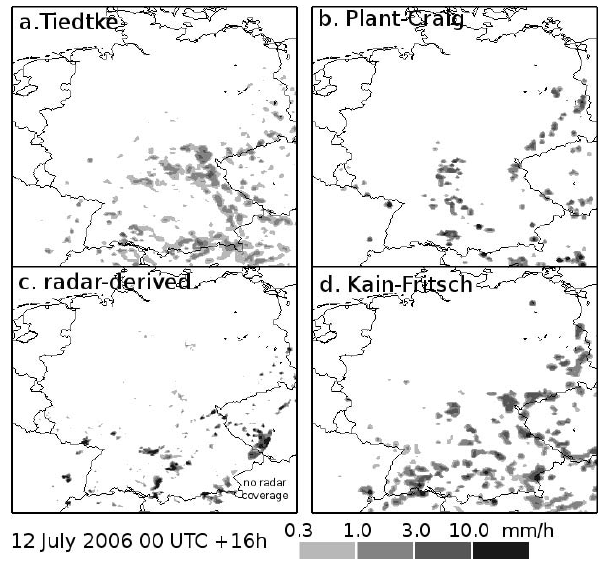
Fig. 3. Comparison of precipitation rates of the Tiedtke (a) , Plant- Craig (b) and Kain-Fritsch (d) convective schemes, and the radar- derived rates (c) 16h after